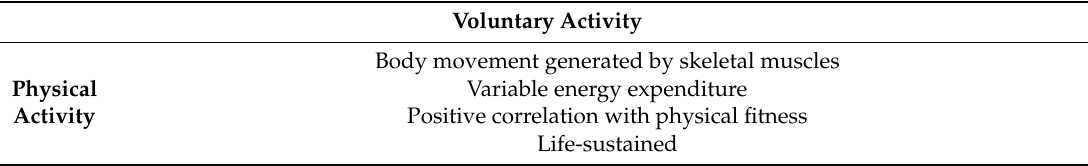
Table 1. Characteristics of physical activity and